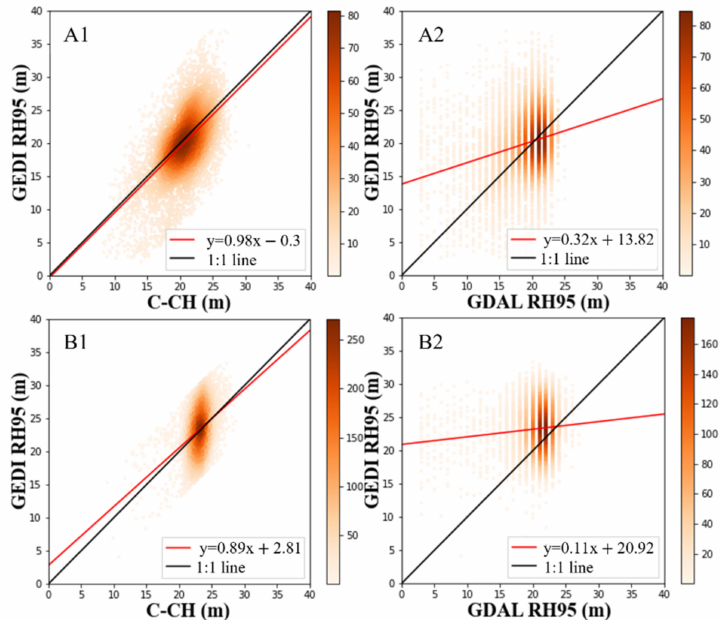
Figure 3. The relationship between canopy heights of C-CH ( A1 , B1 ) and GDAL RH95 ( A2 , B2 ) compared to high-quality GEDI validation data in Area 1 ( A ) and Area 2 ( B ), respectively.